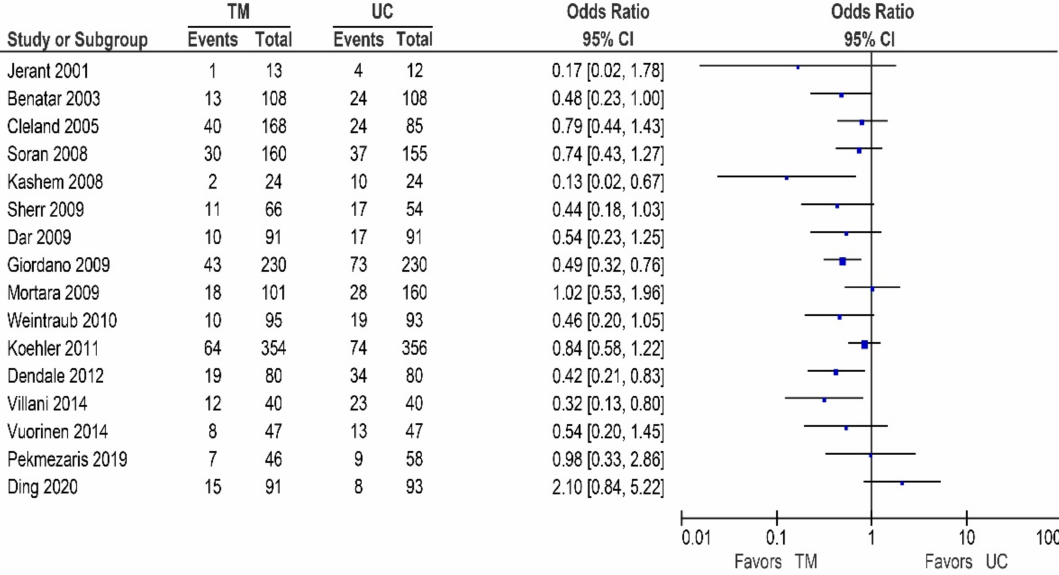
Figure 6. HF-related hospitalizations in patients receiving non-invasive telemonitoring versus usual